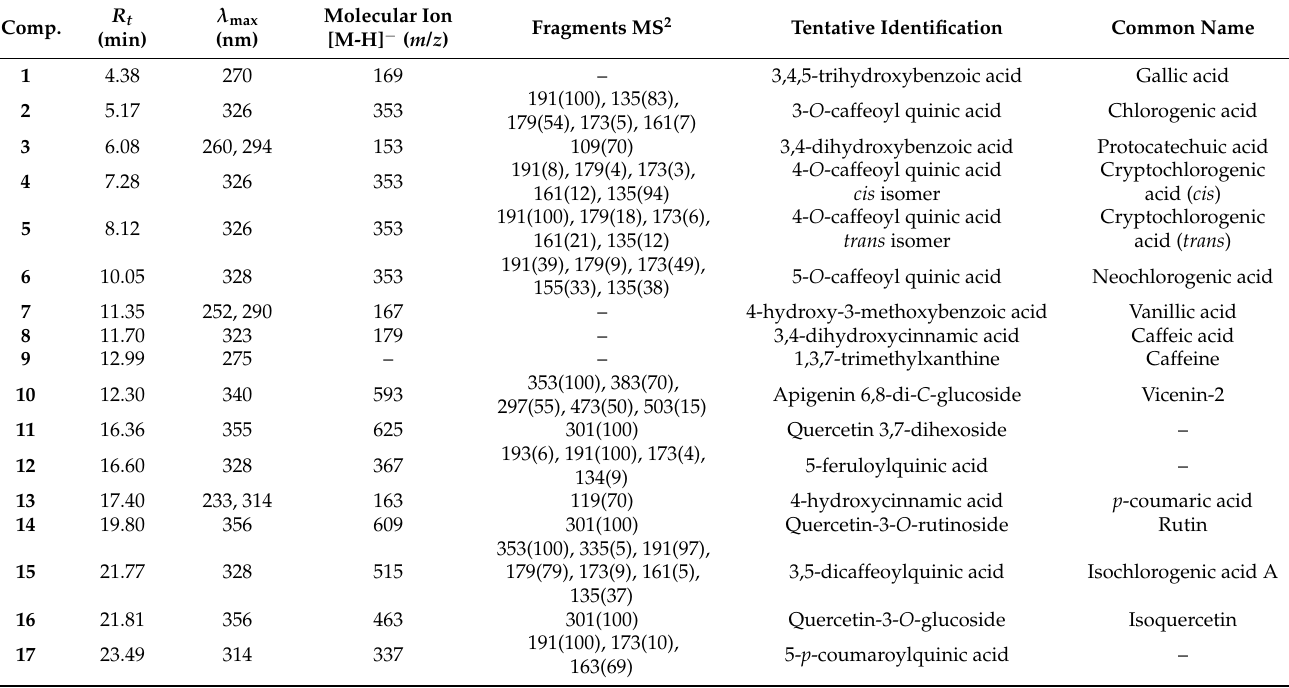
Table 1. Identification of phenolic compounds and methylxanthines in the coffee pulp flour (CPF) and extract (CPE) by HPLC-DAD-MS